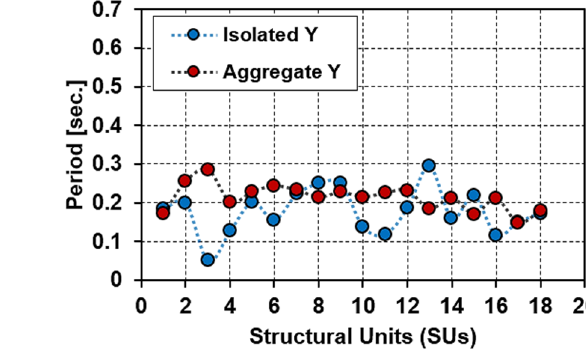
Figure 14. Influence of the structural positions on the fragility assessment of inspected SUs in ( a ) X direction and ( b ) Y analysis directions.